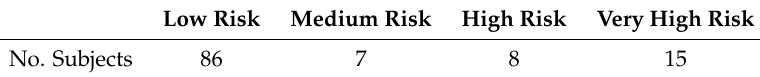
Table 5. Statistics of classes in the created